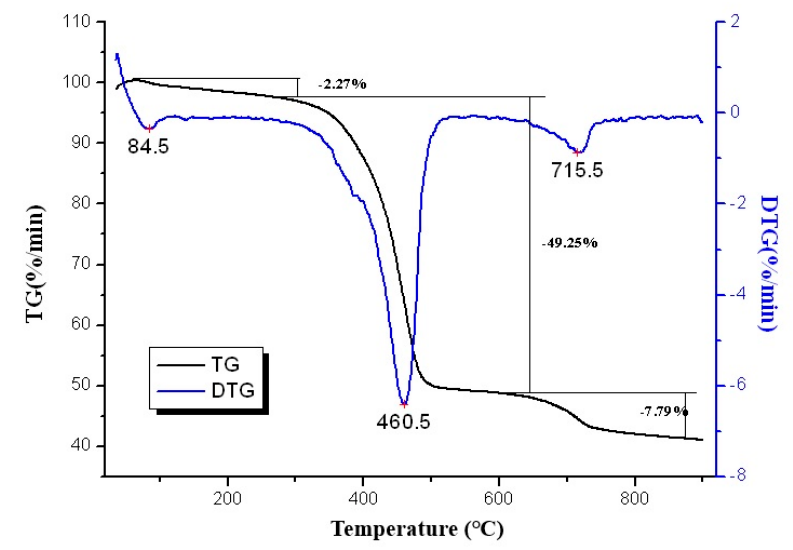
Figure 6. TG-DTG curves of the RSAC sample.